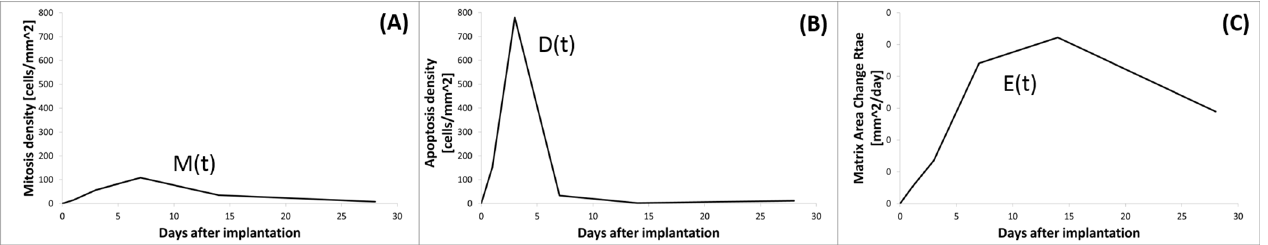
Fig 7. Cellular events dynamic from rabbit model. Cell mitosis rate (A), cell apoptosisrate (B) and ECM synthesis rate (C) are recorded on a post-surgical follow-upof 28 days and harvested at time of implant, and after 2 hours, 1, 3, 7, 14, 28 days.